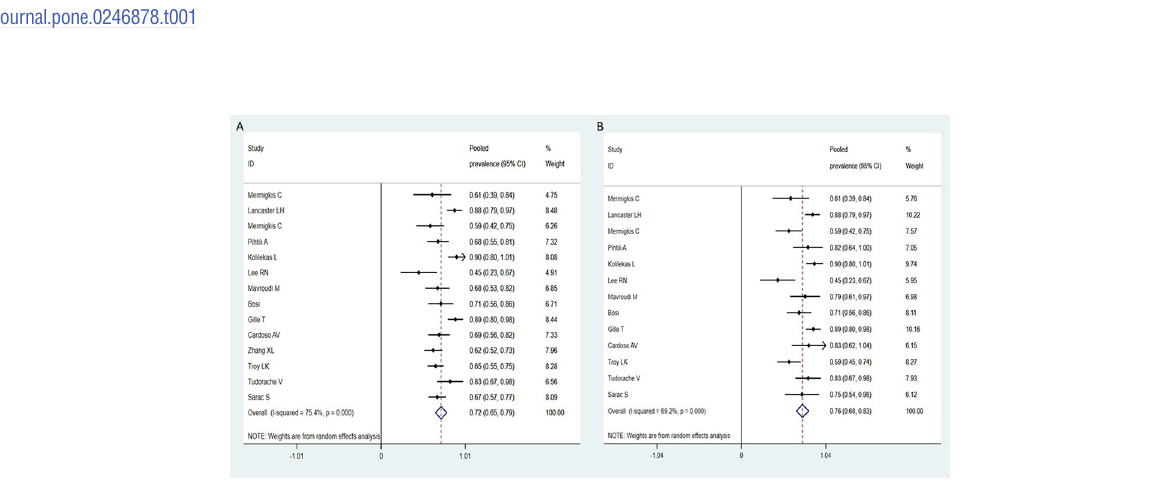
PLOS ONE | https://doi.org/10.1371/journal.pone.0246878 February 11,